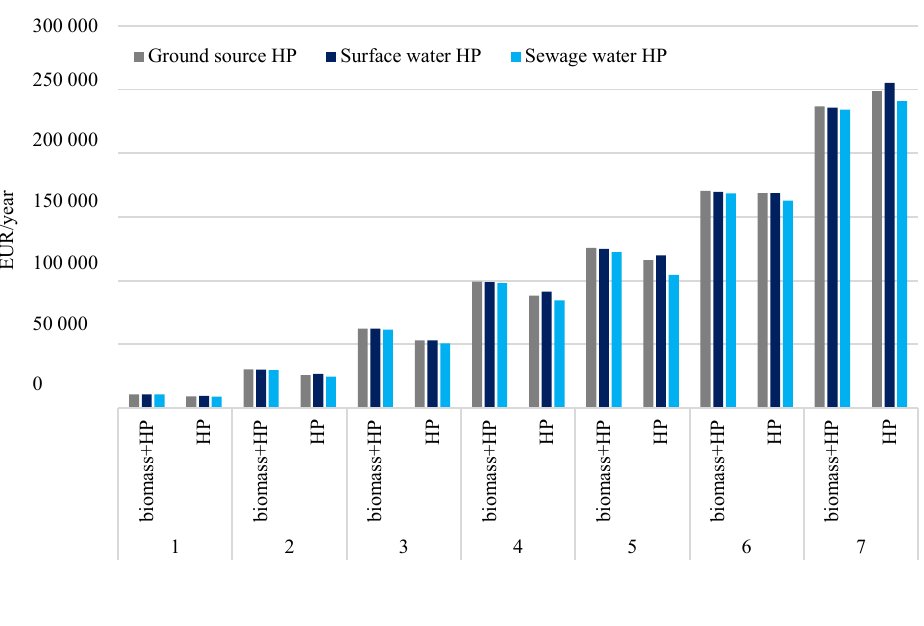
Fig. 4. Annual fuel costs for each